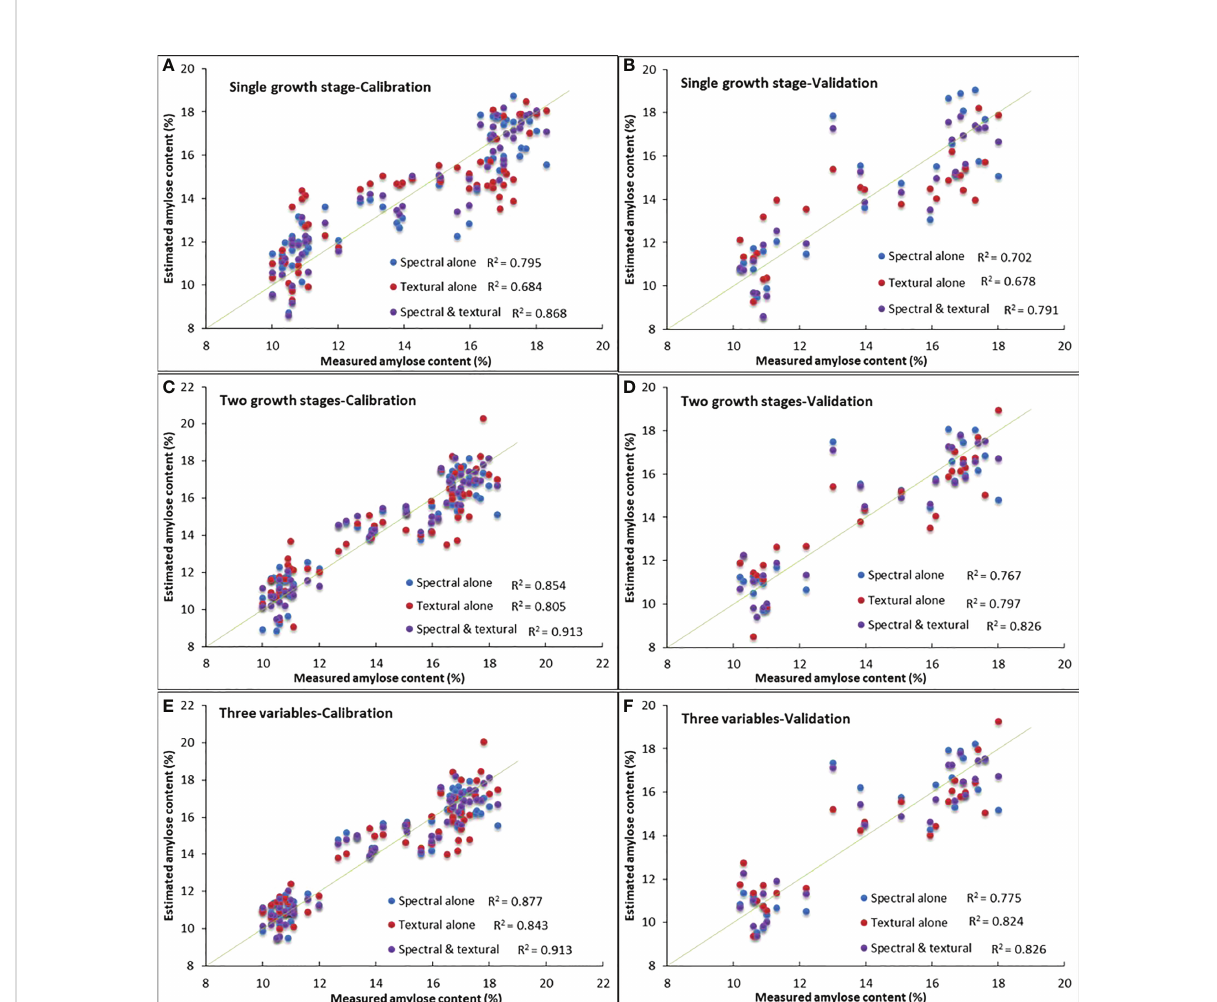
FIGURE 5 Measured vs. estimated amylose content derived from models based on spectral variables alone, textural variables alone, and combined spectral and textural variables. Panels (A , C , E) are results from the calibration dataset. Panels (B , D , F) are results from the validation